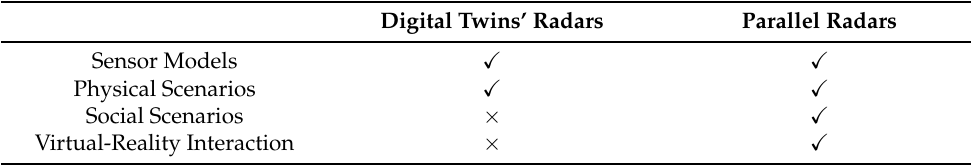
Table 3. Comparison between digital twins’ radars and Parallel